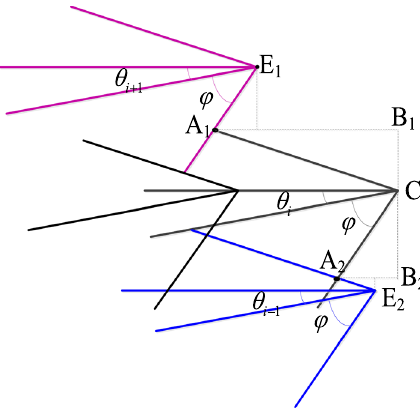
Figure 7. Schematic diagram of intersection point of the crumbling